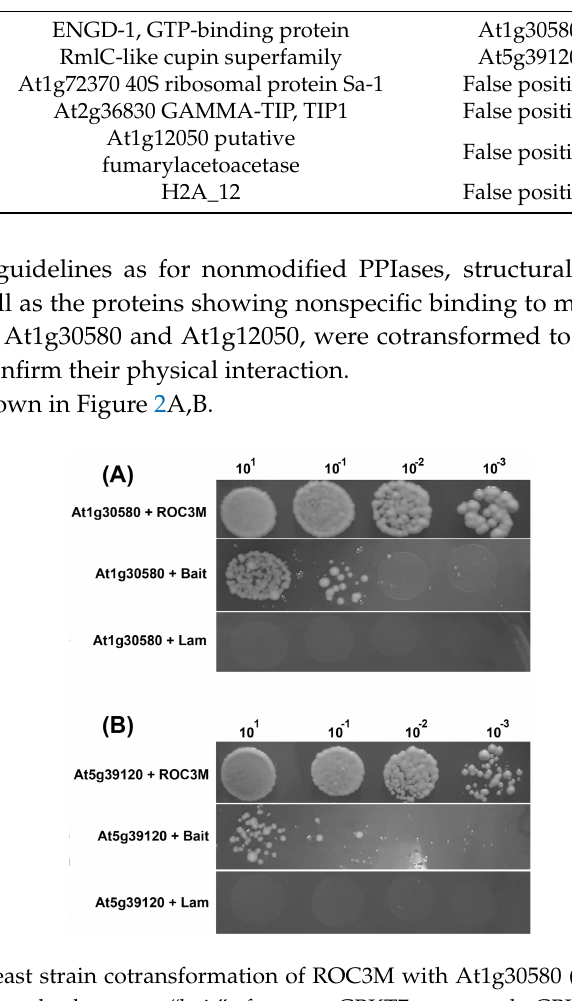
Figure 2. AH109 yeast strain cotransformation of ROC3M with At1g30580 ( A ) and At5g39120 ( B ), and two negative controls: the empty “bait” of empty pGBKT7 vector and pGBKT7 carrying the control gene of the human protein lamin C. The initial culture of OD600 = 0.2 was used, sequentially diluted to 10 − 3